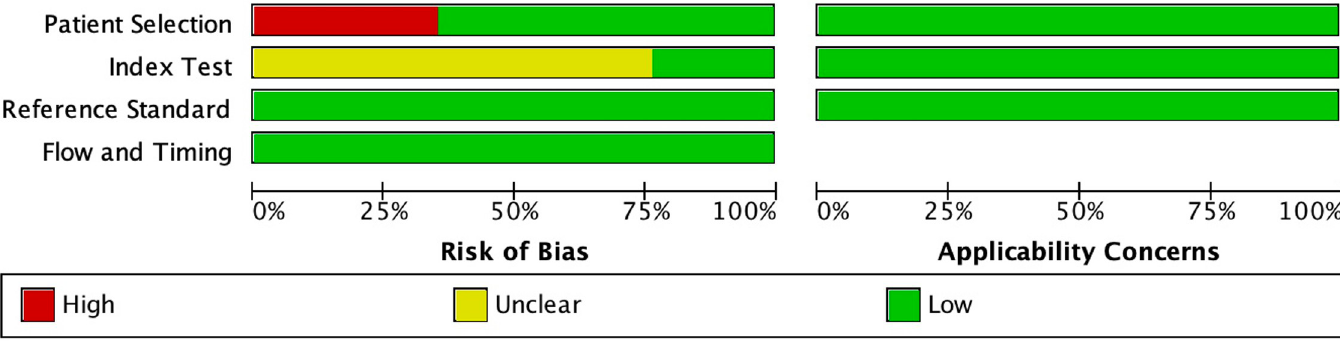
Fig 2. Quality assessment graph of included